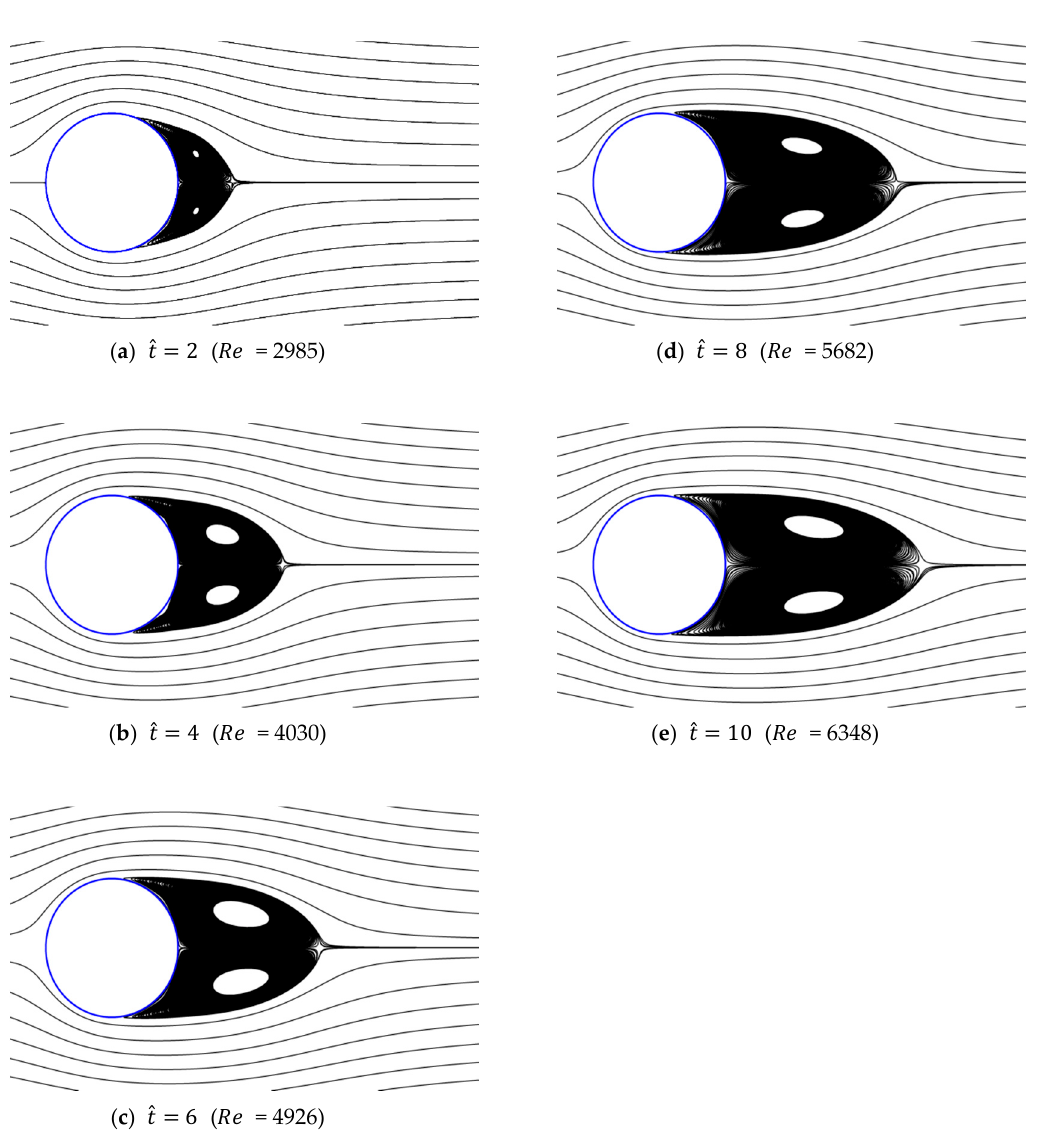
Figure 15. Streamlines around circular cylinder ( a / g = 0.1, Re 0 = 40 )